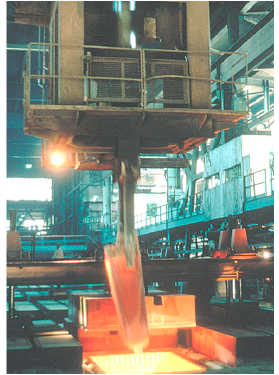
Figure 1. The production route of bars at Ovako Sweden AB, Hofors, Sweden [26].